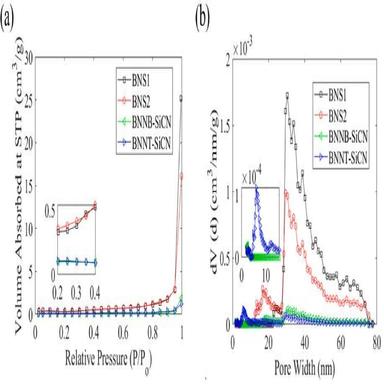
(a) Nitrogen absorption isotherms and (b) pore size distribution of the various samples and no change